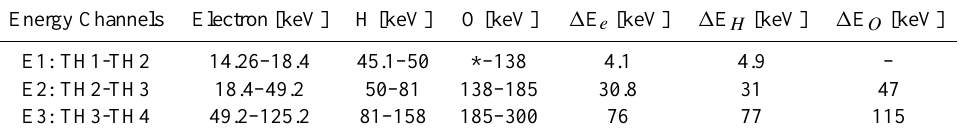
Fig. 2.The location of TC-2 in the X-Y plane (right), and in the X-Z plane (left) in the GSE system. Black arrows indicate the magnetic field direction and red arrows the direction of motion of the spacecraft at the time of the PADs shown in Fig. 1.